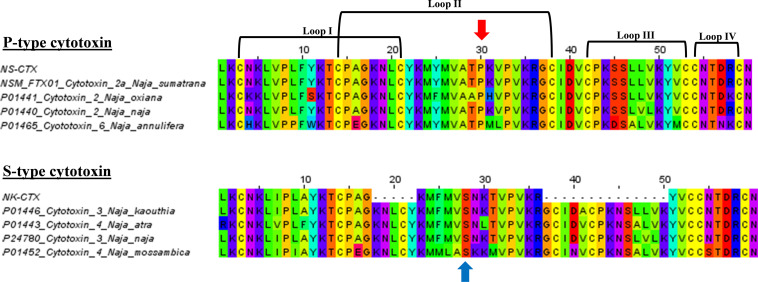
Multiple sequence alignments of NS-CTX and NK-CTX, visualizing P-type and S-type cytotoxins. Arrow in red indicates the Proline30 of P-type cytotoxin; blue arrow indicates the Serine28 of S-type cytotoxin.